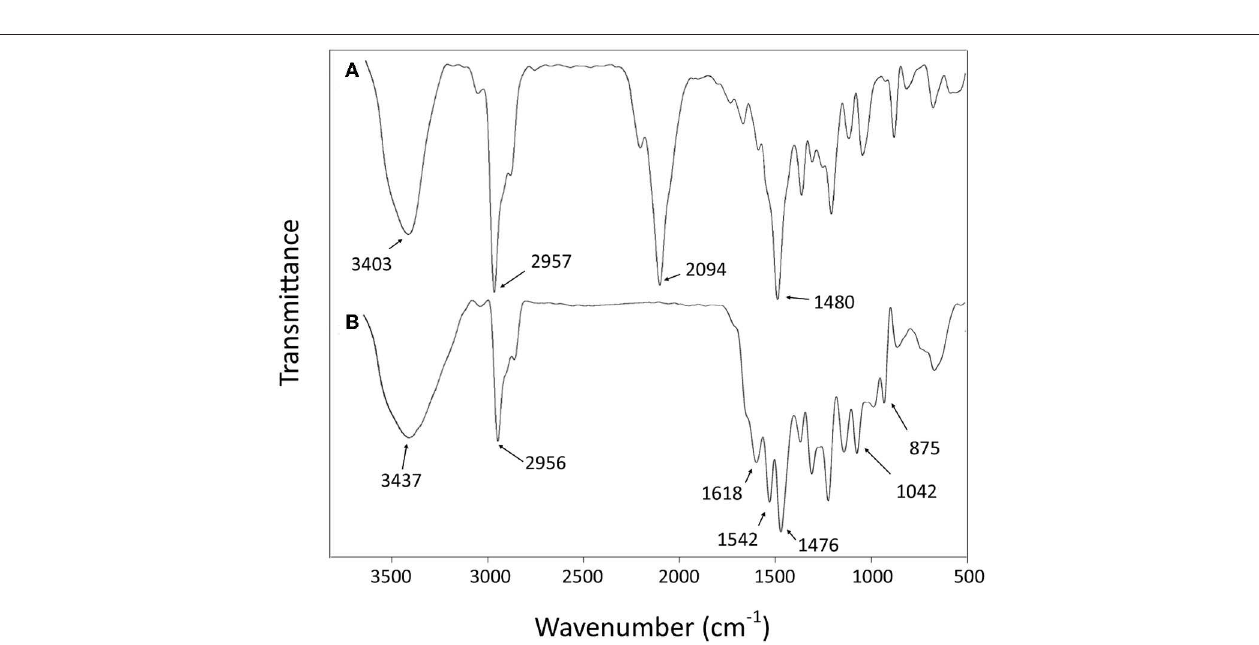
FIGURE 2 | Fourier-transform infrared (FT-IR) spectra of compound 4 (A) and ligand L (B) .